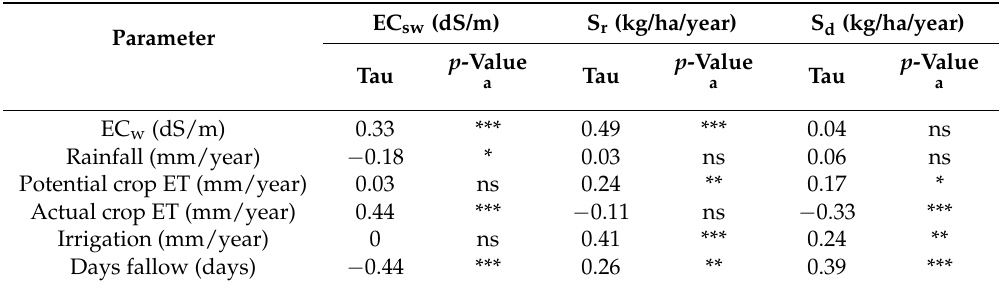
Figure 11. Cumulative salt output loads with runoff and deep percolation from each site. Table 10. Mann–Kendall trend analysis for average annual soil water EC (EC sw ), annual salt output load with runoff (S r ), and with deep percolation (S d ).